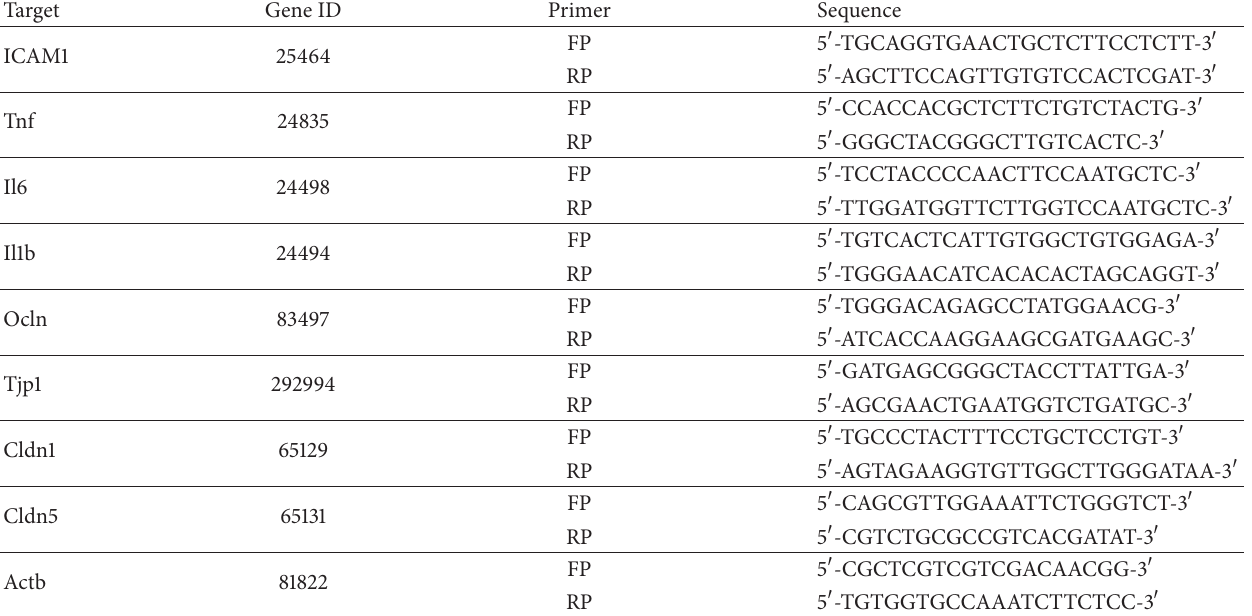
Table 1: List of primers for real-time